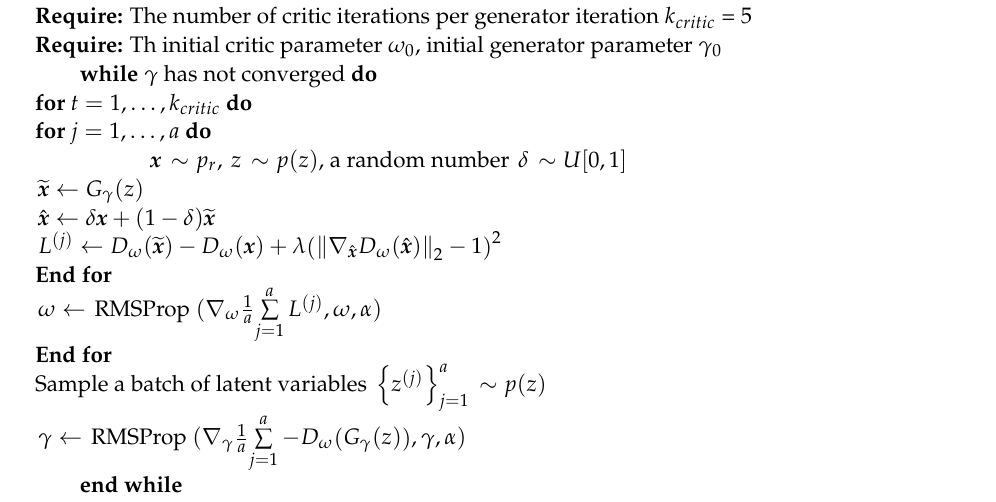
Algorithm 1. The method in this paper is based on WGAN-GP. Some default values are: learning rate α = 0.00001, batch size a = 128, λ =